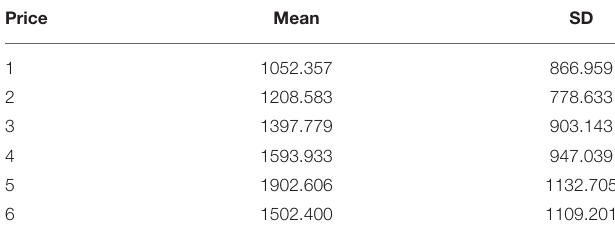
TABLE 6 | Descriptive statistics for the evaluation levels of the Price dimension. Price